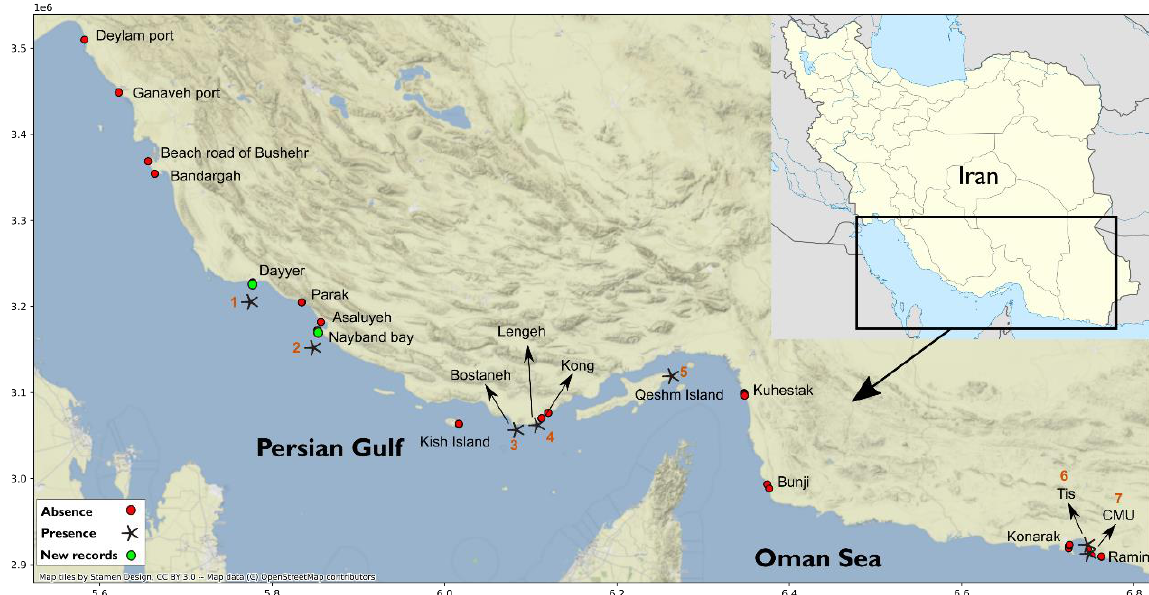
F IGURE 1. Sampling localities at the coast of the Persian Gulf and the Gulf of Oman. At localities marked by red circles no brittle stars were found, stars indicate the presence of brittle stars, and green circles mark new geographical records. At seven stations out of 22, the brittle stars were collected during the sampling time. The presence of O. scolopendrina from two stations is reported for the first time. Each locality includes several sampling